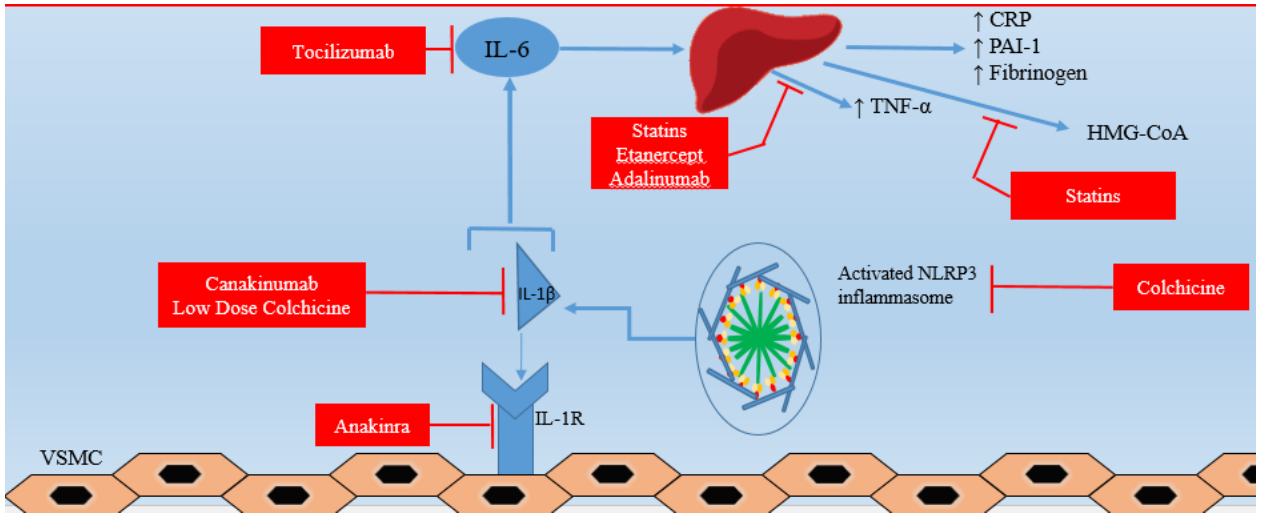
Figure 2. Anti-inflammatory approaches in cardiovascular diseases. IL: interleukin; NLRP3: NOD-like receptor protein 3; TNF: tumor necrosis factor; CRP: C reactive protein; PAI: plasminogen activator inhibitor; VSMC: Vascular Smooth Muscle Cell; HMG-CoA: 3-hydroxy-3-methylglutaryl-CoA.